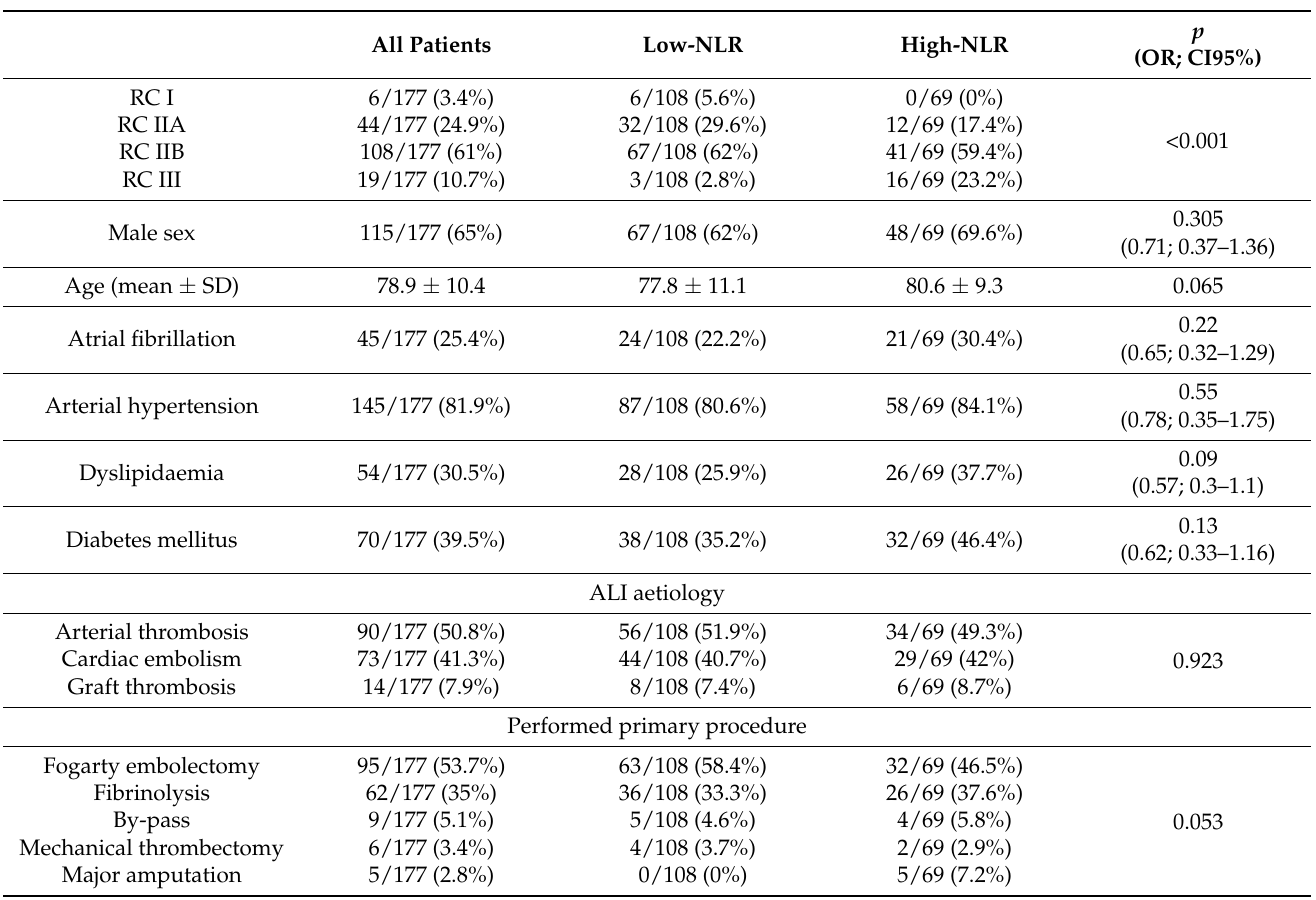
Table 1. Demographic, clinical, and procedural characteristics of all patients included in the analysis and of the two sub-groups evaluated according to low- and high-LNR baseline